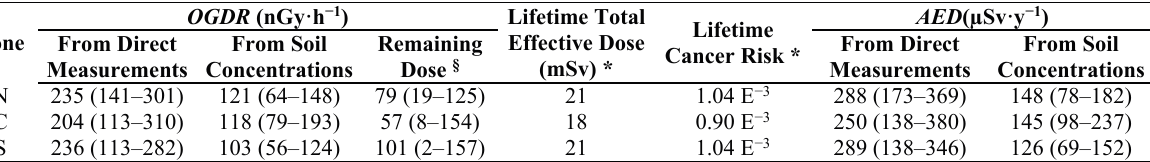
Table 3. Natural gamma radiation doses, average and range, obtained from the ground in Chihuahua